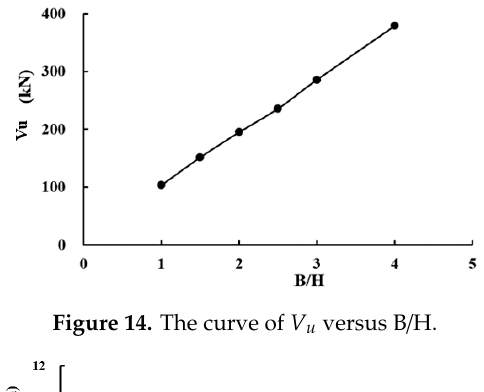
Figure 14. The curve of (cid:1848) (cid:3048) versus B/H.